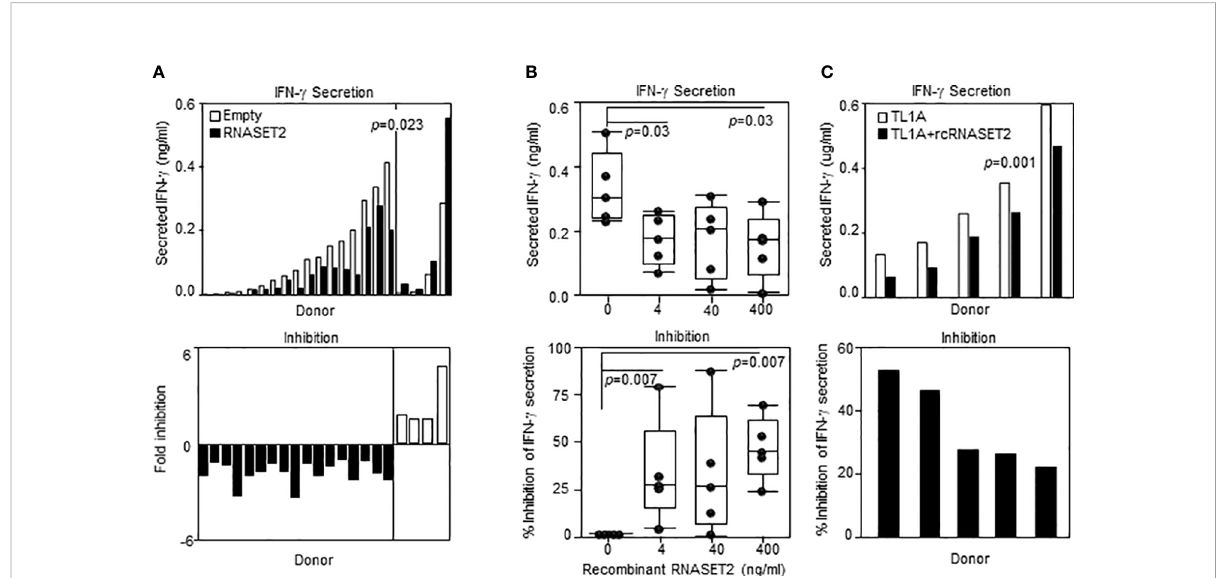
FIGURE 8 Recombinant RNASET2 attenuates IFN- g secretion in a dose dependent manner. CD4 + T cells were either (A) Transfected with RNASET2 overexpression vector ( n =21) or (B) Treated with recombinant RNASET2 prior to TL1A stimulation ( n =5). (C) Resting PBMC isolated from IBD subjects (CD n =2; UC n =3) treated with 400 ng/ml recombinant RNASET2 protein. IFN − g secretion was measured after 24 hours. Bottom panels depict fold inhibition in IFN − g secretion comparing overexpression vs. empty vector or recombinant RNASET2 treatment vs. no recombinant